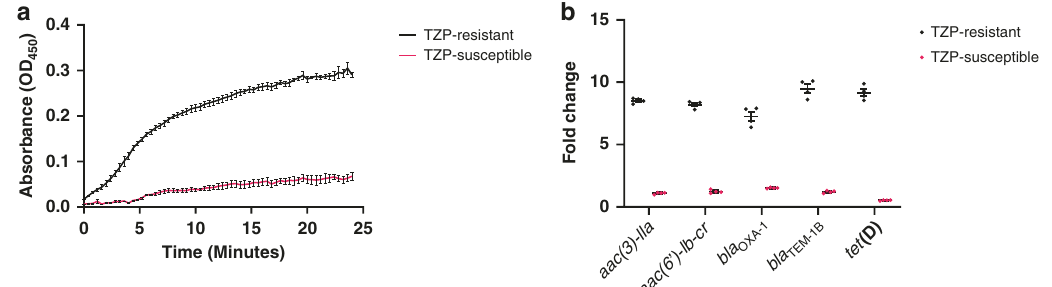
Fig. 1 Hyperproduction of TEM-1B in the piperacillin/tazobactam-resistant isolate is mediated by an increase in copy number. a Increase in nitroce fi n hydrolysis by the piperacillin/tazobactam (TZP)-resistant isolate (black line) compared to the TZP-susceptible (pink line) isolate, as measured at an optical density of 450 nm (OD 450 ) , due to hyperproduction of a β -lactamase in the TZP-resistant isolate. All error bars represent the standard error of the mean ( n = 3). b Comparison of the fold change in copy number of the antimicrobial resistance genes present on the pseudo-compound transposon of the TZP- susceptible isolate (pink circles)/translocatable unit (TU) of the TZP-resistant isolate (black circles) as assessed by qPCR of a single DNA extract compared to the housekeeping gene uidA . All error bars represent the standard error of the mean ( n = 4). Source data are provided as a Source Data fi